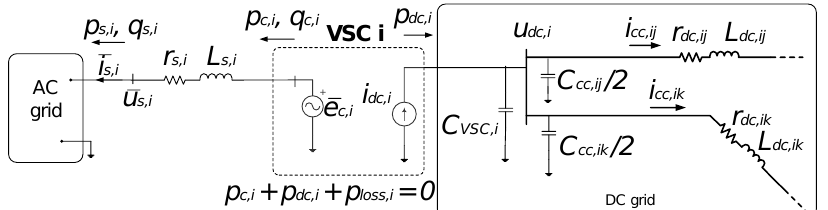
Figure 2. Model of a VSC and the DC grid